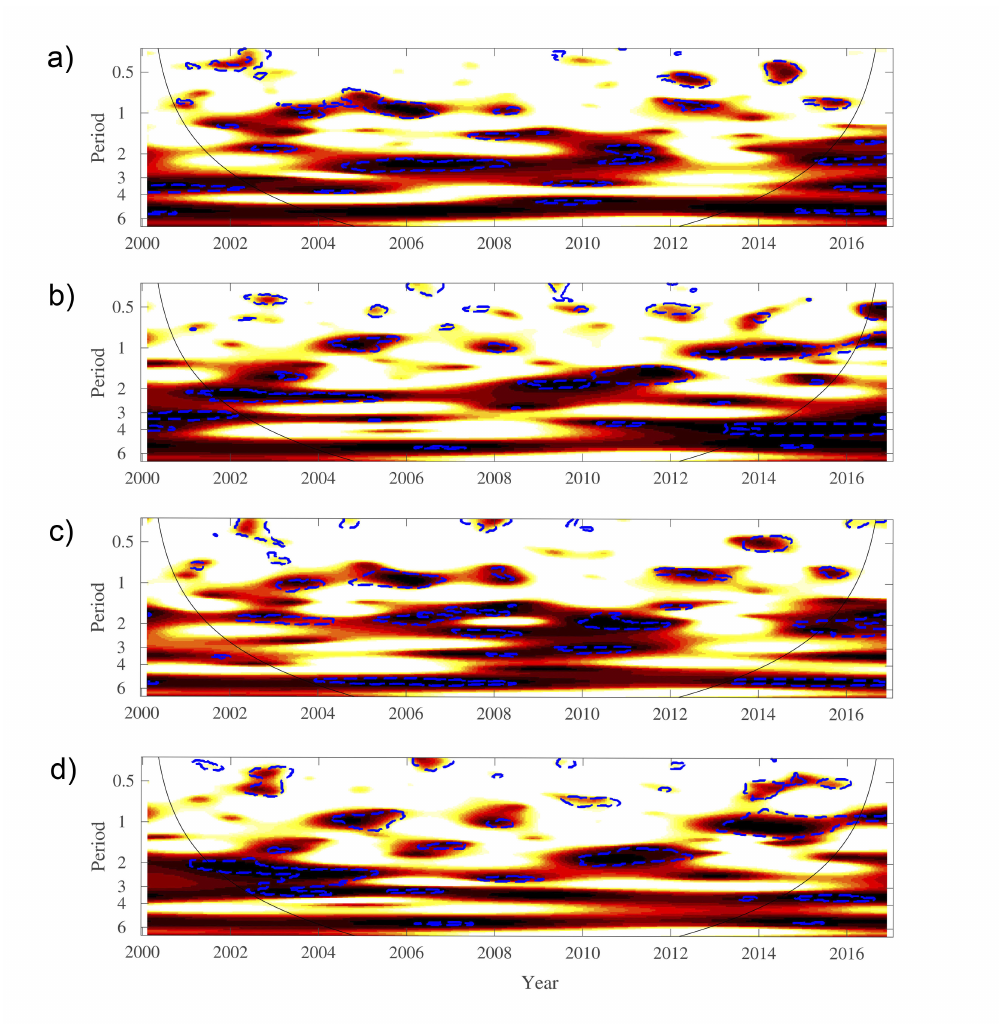
Figure 4. Wavelet coherence between ( a ) EVI and ENSO in northern region; ( b ) EVI and AAO in northern region; ( c ) EVI and ENSO in southern region and ( d ) EVI and AAO in southern region. The colors coded for low coherence in white to high coherence in dark red. The blue dashed lines indicate the 95% and 90% statistically significant areas computed with adapted bootstrapping (see [34]). The cone of influence (black curve) indicates the region not influenced by edge